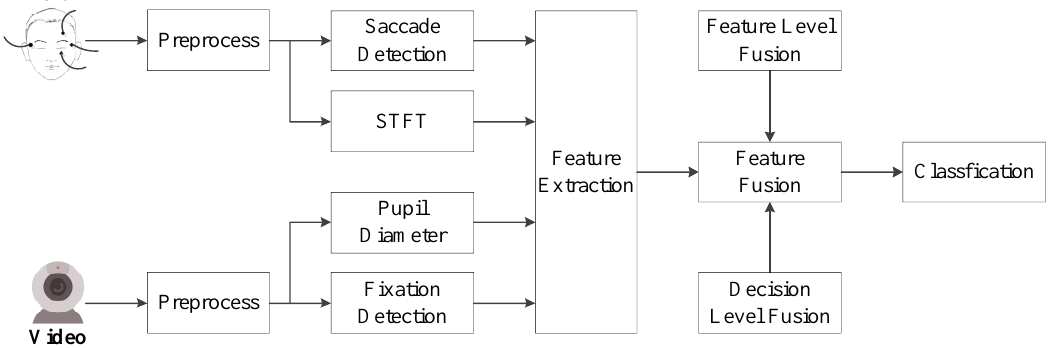
Figure 2. The architecture of the proposed emotion recognition algorithm based on eye movement information.